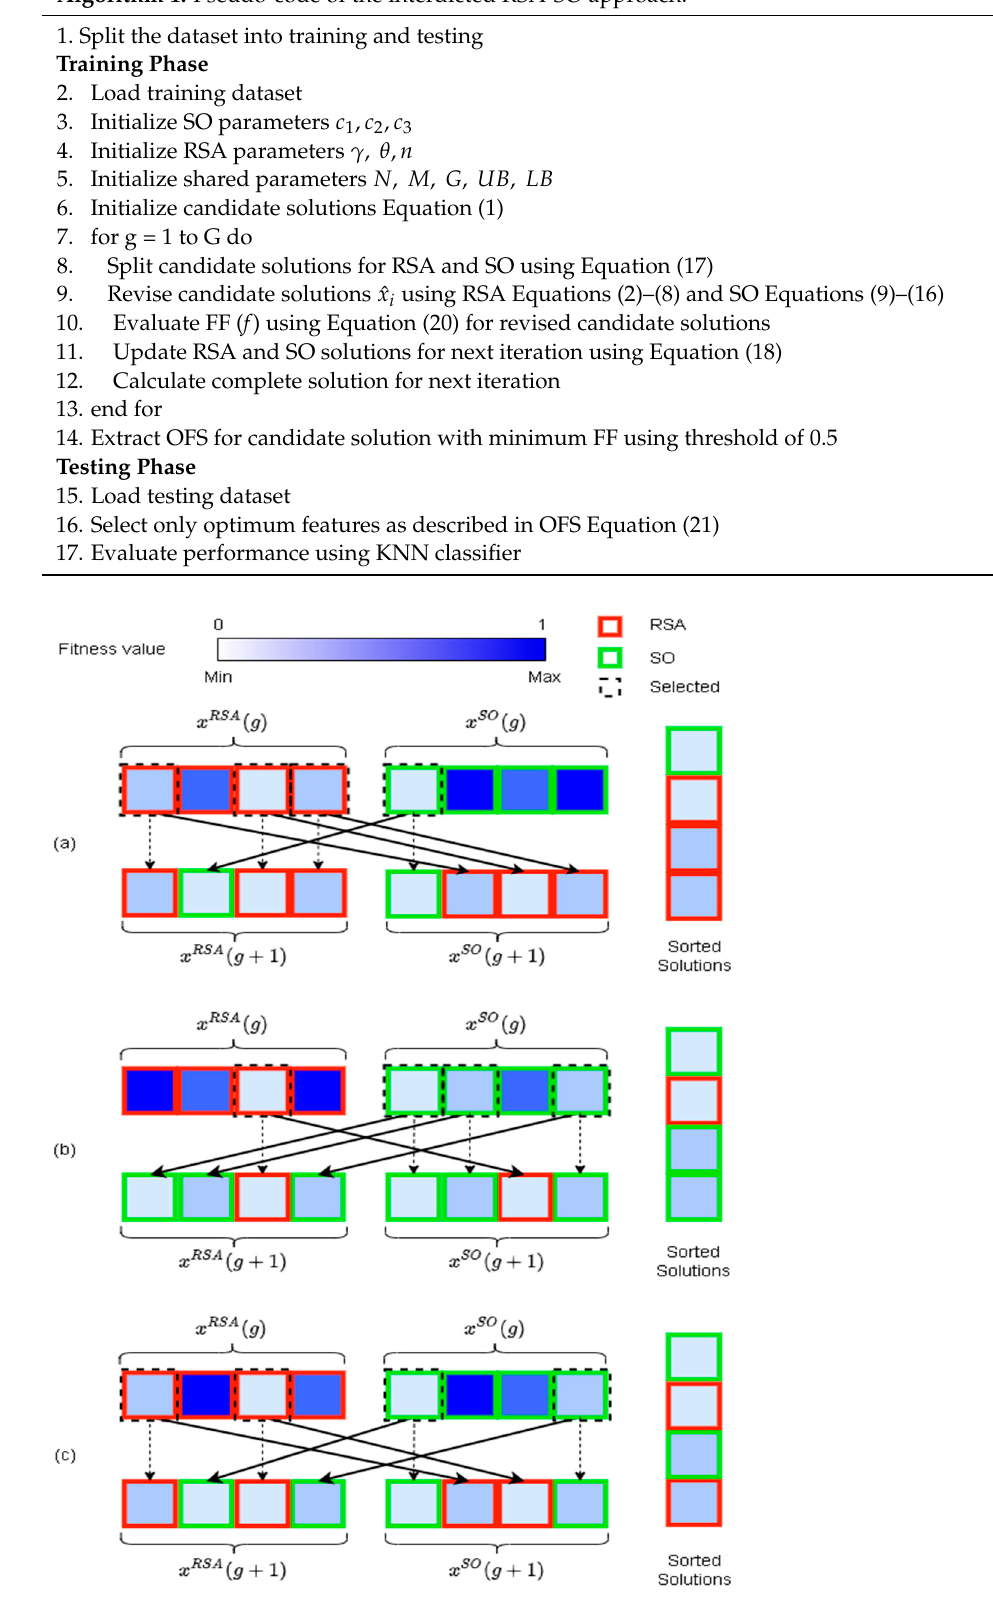
Algorithm 1: Pseudo-code of the interdicted RSA-SO approach.